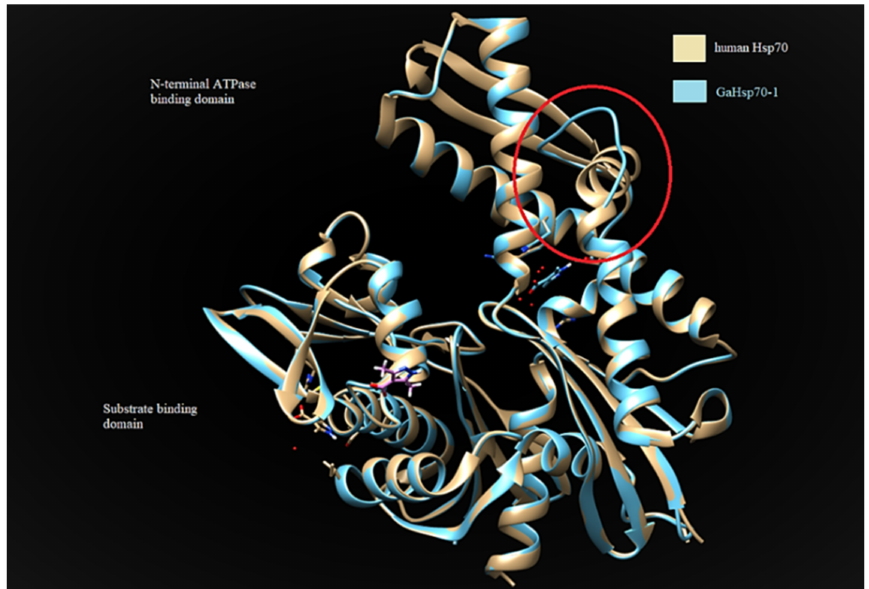
Figure 4. Comparative structural analysis between GaHSP70-1 model and human HSP70 (PDB 5FPN). The red circle indicates the substitution of a β -sheet for a loop located at the N-terminal ATPase of GaHSP70-1. The structures were visualized using CHIMERA UCSF [40].